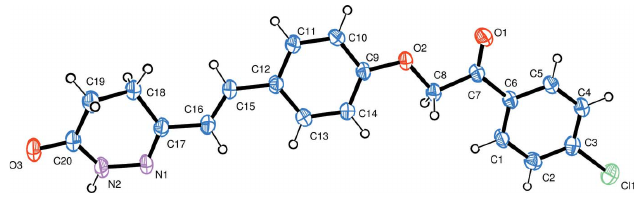
Table 2 Hydrogen-bond geometry (A˚ , (cid:2) ).